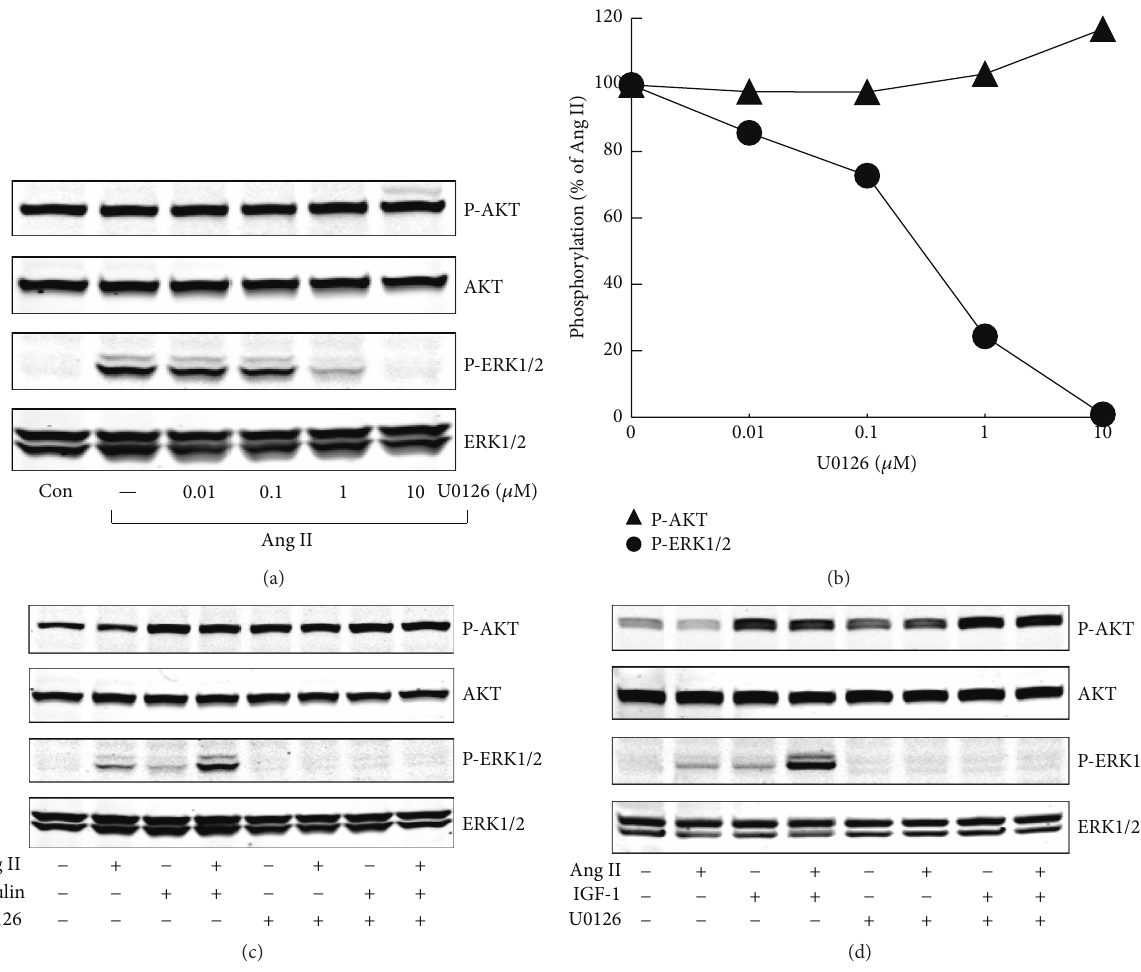
Figure 4: Involvement of MEK in agonists-stimulated phospho-ERK1/2 and phospho-AKT in H295R cells. (a) Effects of U0126, a MEK1/2 inhibitor, on Ang II-induced ERK1/2 and AKT phosphorylation. H295R cells were treated with increasing concentrations of U0126 for 30 min and then stimulated with Ang II (100nM) for 5 min. (b) Quantitative determination of the effects of U0126 on ERK1/2 and AKT phosphorylation by Ang II from panels (a). (c and d) After incubation with U0126 (10 𝜇 M) for 30min, H295R cells were pretreated with Ang II for another 30 min and then stimulated with insulin/IGF-1 for 5min. (c) Insulin (100nM); (d) IGF-1